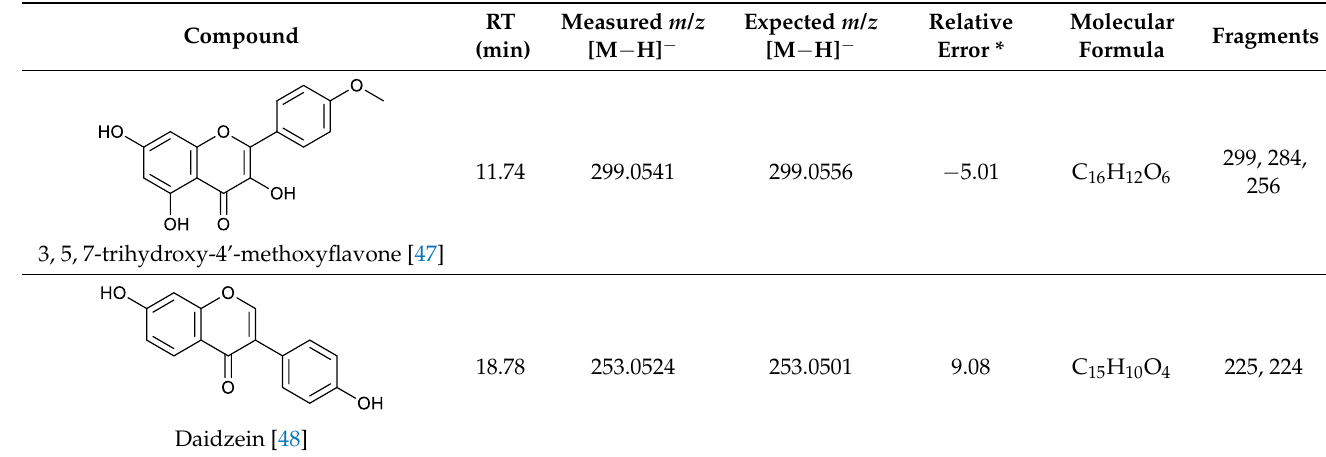
Table 3. Chemical constituents of T. sanguinea extract newly identified by LC-ESI-TOF-MS/MS analysis (positive ion mode). Compound